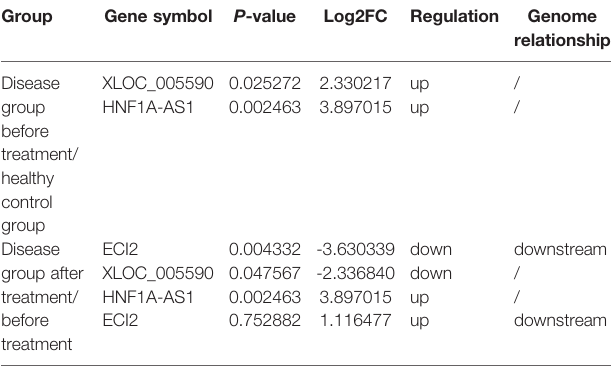
TABLE 5 | Expression of XLOC_005590, HNF1A-AS1 and ECI2 in gene chip.